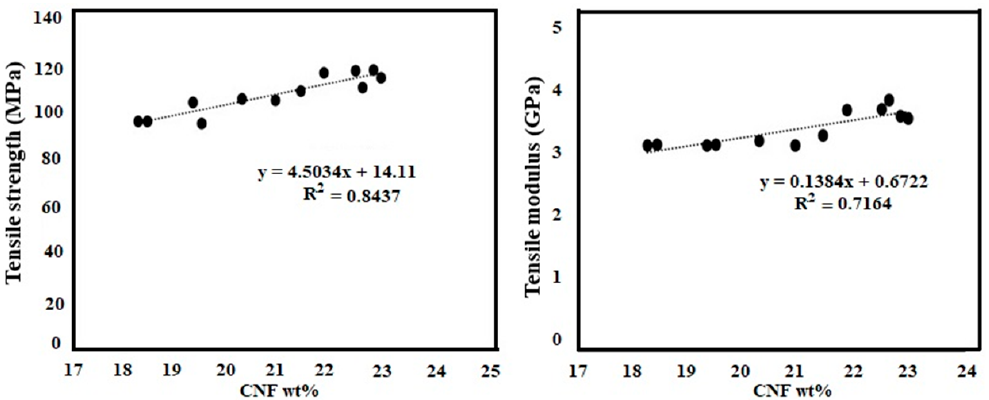
Figure 3. Mechanical properties of the CNF/epoxy composites. Table 1. Mechanical properties of CNF film cured neat epoxy resin, and composites.